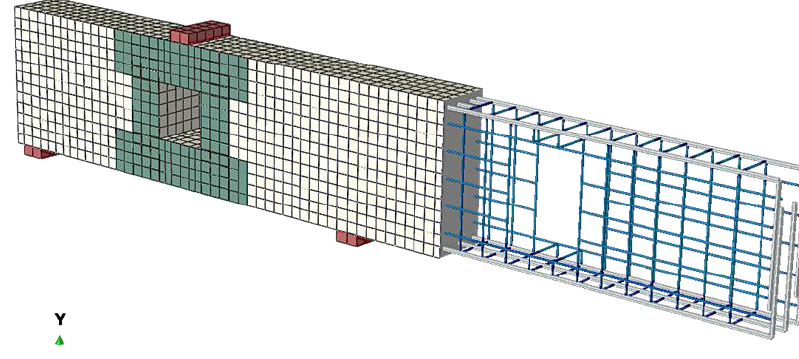
Figure 9. FE mesh and discretization.